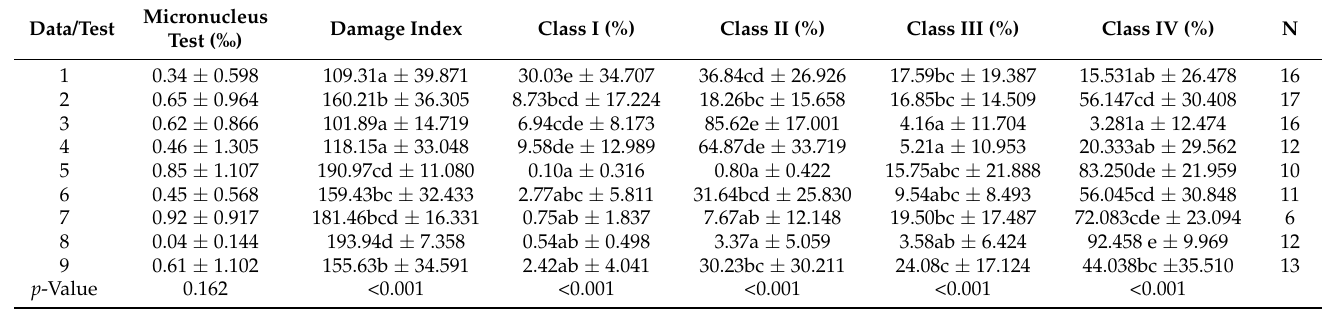
Table 6. Micronucleus test and DNA damage index evaluated by comet assay during the months in which the M ã e-B á Lagoon was monitored (mean ±